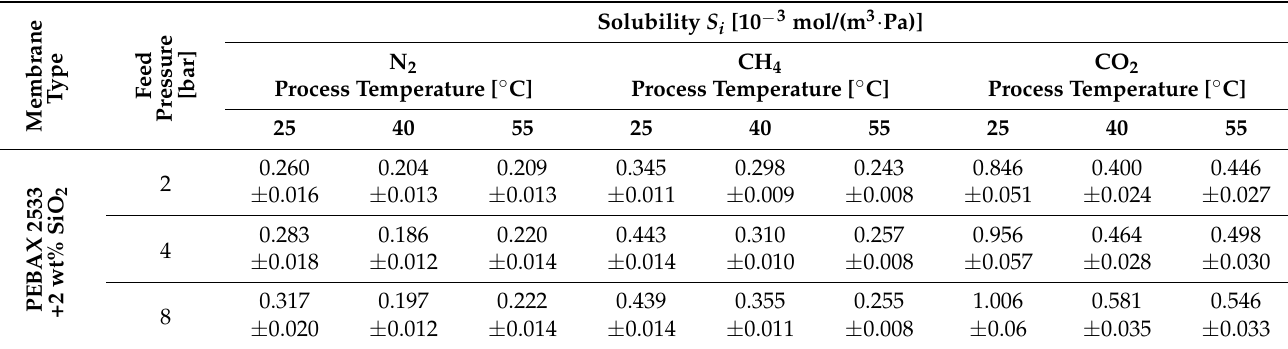
Table A10. Solubility coefficient of heterogeneous membranes containing SiO 2 to different gases measured for different feed pressure and temperature